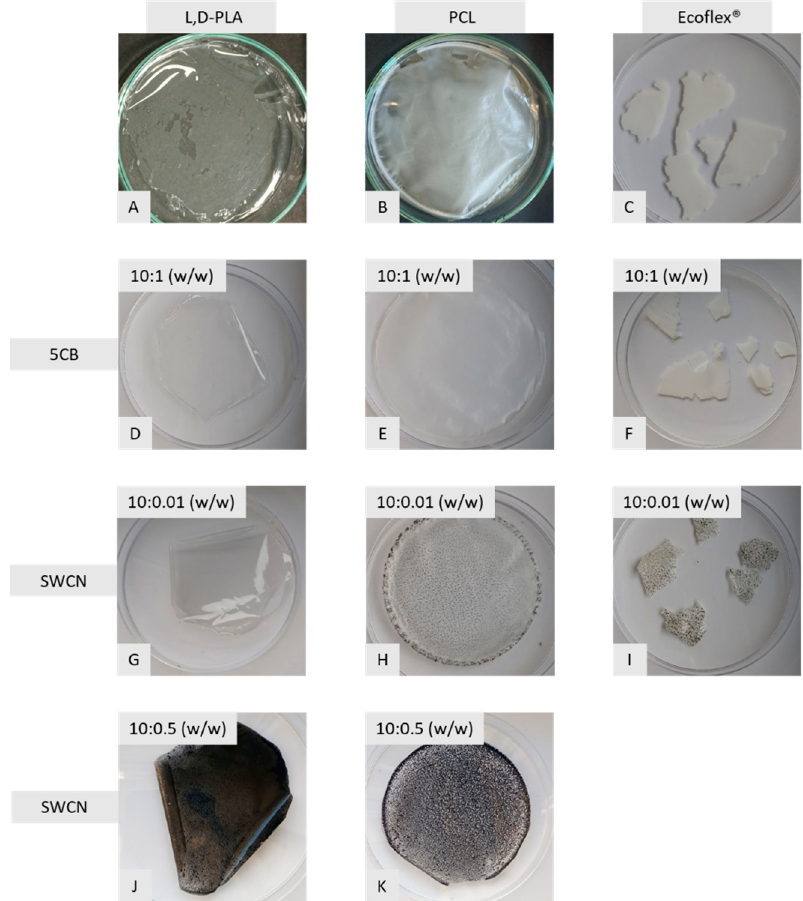
Figure 4. Photos of the created polymer layers by the drop-casting method: polymers L,D-PLA ( A ), PCL ( B ), Ecoflex ® ( A – C ), polymers with 5CB in a ratio of 10:1 ( w / w ) ( D – F ), polymers with SWCN in a ratio of 10:0.01 ( w / w ) ( G – I ), and polymers with SWCN in a ratio of 10:0.5 ( w / w ) ( J , K ).